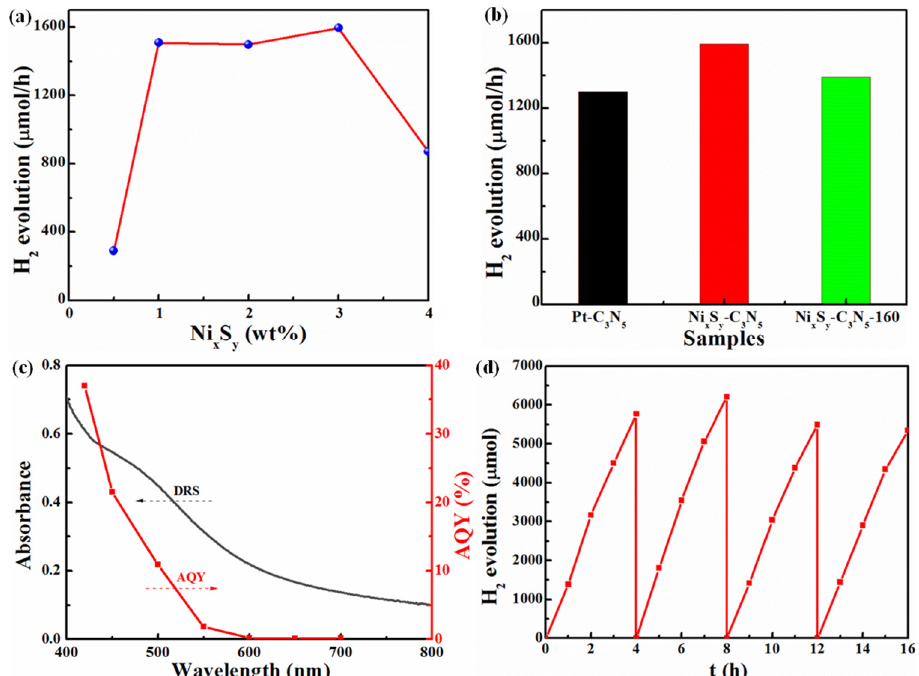
Figure 6. ( a ) Influence of Ni x S y loading amount on the H 2 production rate of Ni x S y -C 3 N 5 hybrid. ( b ) Comparison of H 2 production rate over Pt-C 3 N 5, Ni x S y -C 3 N 5 and Ni x S y -C 3 N 5 -160. ( c ) Change tendency of AQY values along with irradiated wavelength on Ni x S y -C 3 N 5 . ( d ) Long-term test for H 2 production on Ni x S y -C 3 N 5 . Conditions: 45 mg catalyst, 30 mL 10 wol% TEOA/H 2 O aqueous solution, λ > 420 nm (for a , b , d ), λ = 420, 450, 500, 550, 600, 650, 700 nm (for c ).